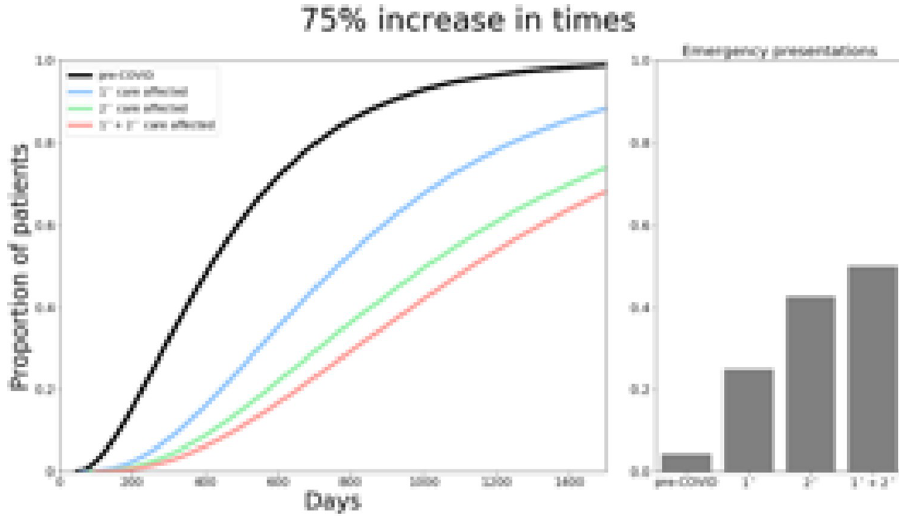
Fig 4. Total time from symptom onset to diagnosis and proportion of emergency presentations if primary, secondary and both care services are increased by 75%.